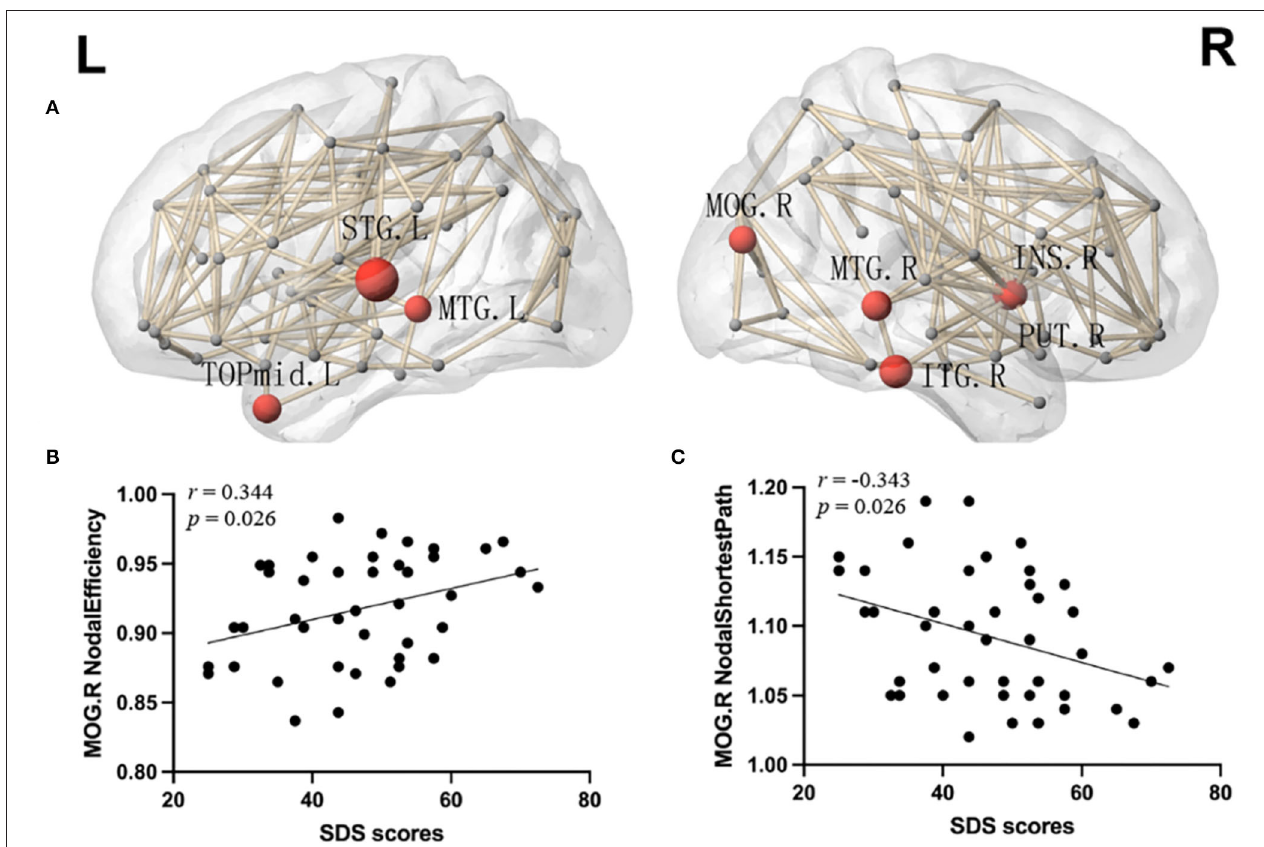
FIGURE 3 | (A) Network hubs were colored in red to indicate significantly lower nodal efficiency and the node sizes indicate the significance ( p < 0.05, FDR). INS, insular; MOG, middle occipital gyrus; PUT, putamen; STG, superior temporal gyrus; MTG, middle temporal gyrus; TPOmid, temporal pole of middle temporal gyrus; ITG, inferior temporal gyrus; L, left; R, right. (B) Correlation analyses between the SDS score and nodal efficiency of the right middle occipital gyrus. (C) Correlation analyses between the SDS score and nodal shortest path in the right middle occipital gyrus. SDS, Self-rating Depression